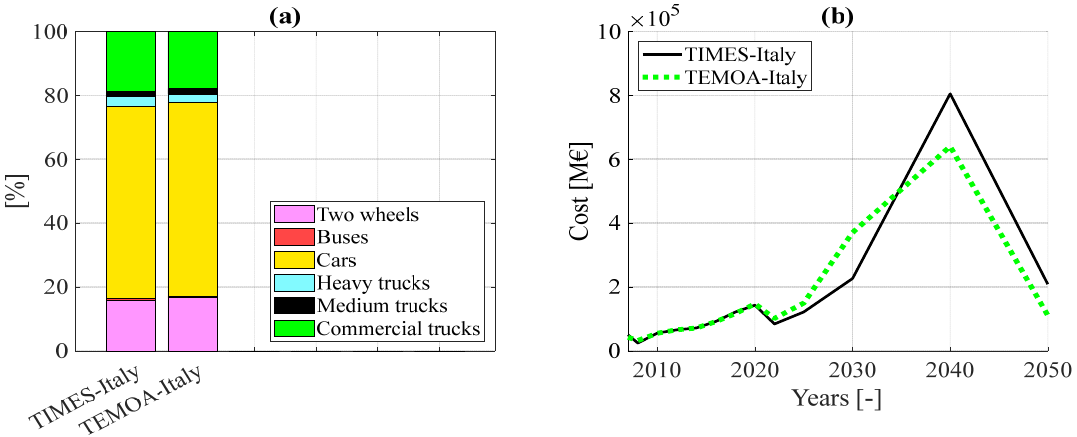
Figure 11. Comparison between the cumulative total cost of the transport sector: ( a ) percentage sub-sectorial contributions; ( b ) evolution in time.